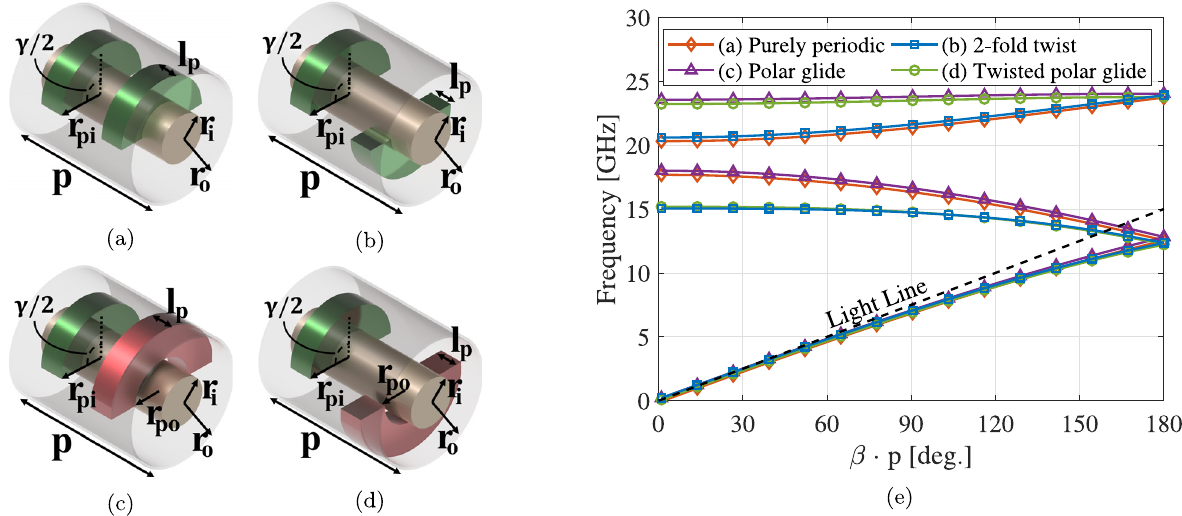
Fig. 3. Simulated structures in the study of polar glide symmetry. Studied structures: (a) purely periodic, (b) 2-fold twist, (c) polar glide, and (d) twisted polar glide symmetry; (e) Dispersion diagram using the dimensions: b =180 (cid:3) , r pi =2.3 mm, r po = 1.08 mm, l p = 1 mm, r i =1 mm, r o =2.5 mm, and p = 6